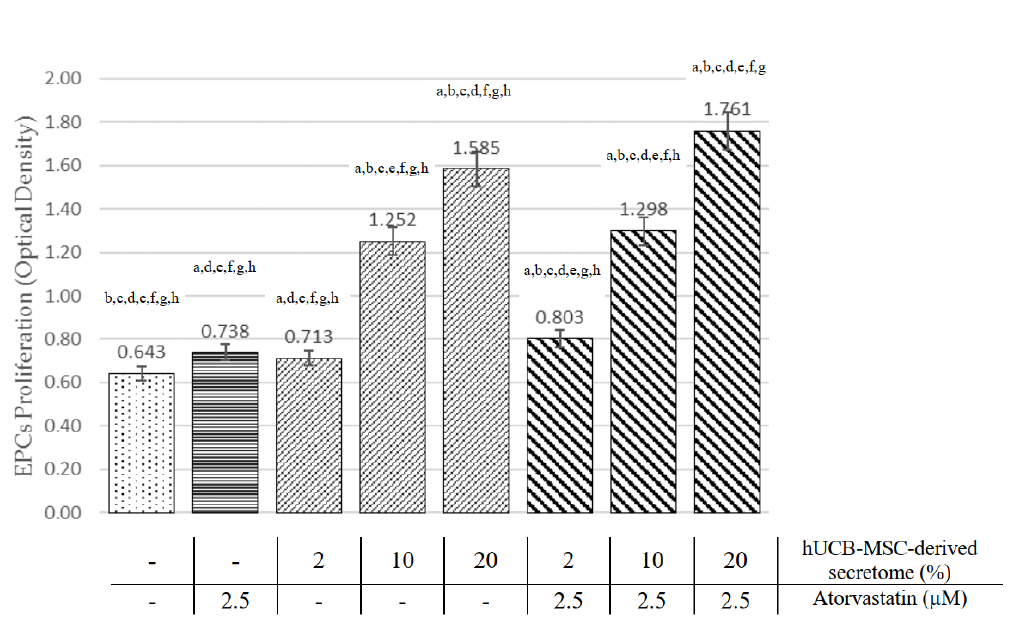
Figure 2. Comparison of EPC proliferation effects among all treatment groups (see text). a Significant difference compared to the control group (p < 0.001). b Significant difference compared to the 2.5 µM atorvastatin group (p < 0.001). c Significant difference compared to the 2% hUCB-MSC-derived secretome group, (p <0.001). d Significant difference compared to the 10% hUCB-MSC-derived secretome group (p < 0.001). e Significant difference compared to the 20% hUCB-MSC-derived secretome group (p < 0.001), f Significant difference compared to the combination of 2% hUCB-MSC-derived secretome and atorvastatin group, (p < 0.001), g Significant difference compared to the combination of 10% hUCB-MSC-derived secretome and atorvastatin group, (p < 0.001). h Significant difference compared to the combination of 20% hUCB-MSC-derived secretome and atorvastatin group, (p < 0.001)